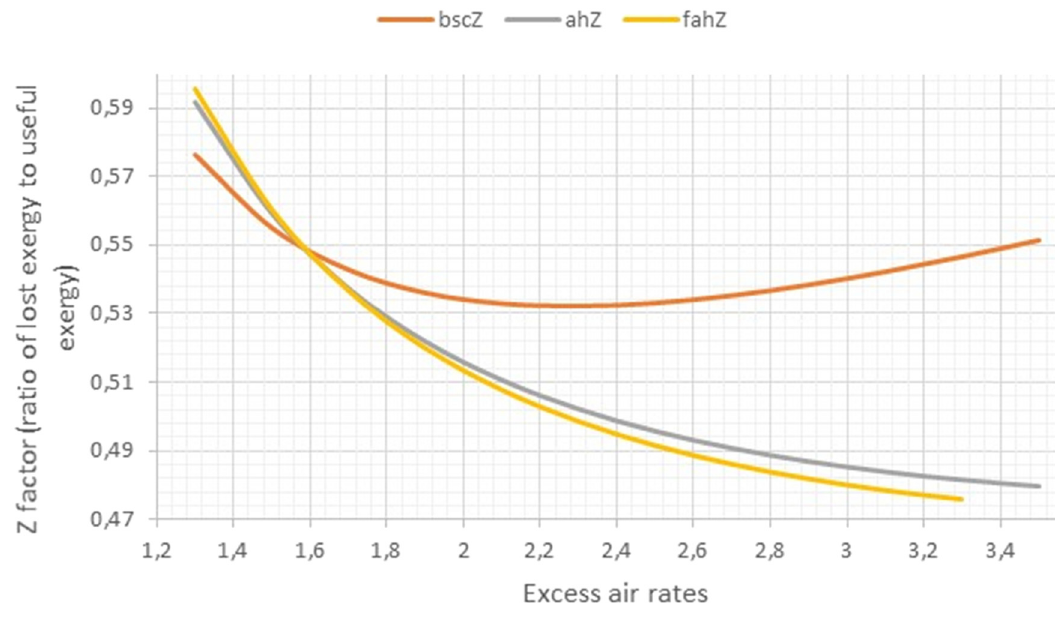
Figure 6: Variation of the Z factor with excess air rates for bsc, ah and fah cogeneration